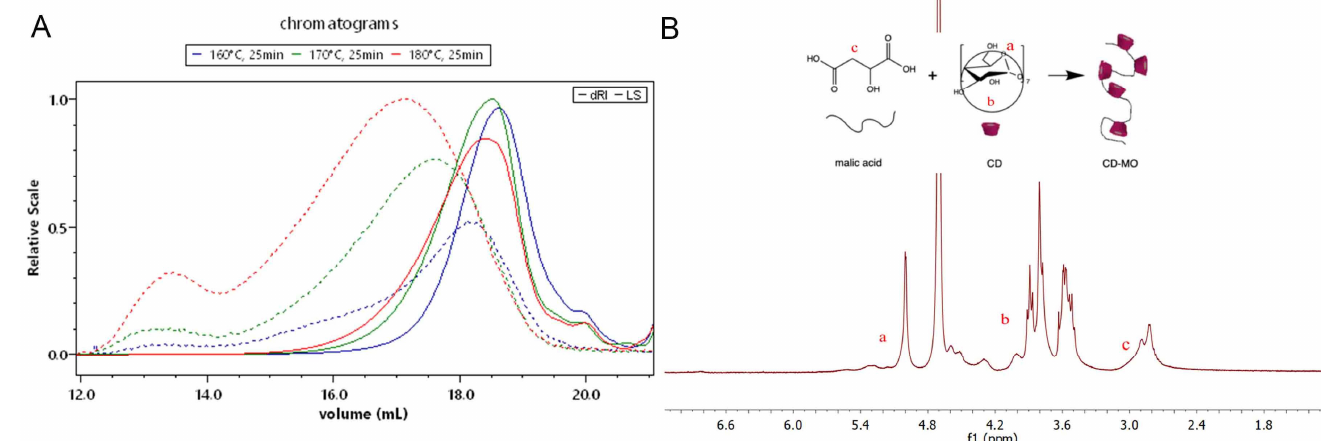
Figure 4. ( A ) SEC/MALS/DRI chromatograms of CD-MO synthesized at 160 °C (purple), 170 °C (green), and 180 °C (red) for 25 min showing both dRI and LS signals; ( B ) 1 H NMR spectrum of CD-MO synthesized at 160 °C, 25 min. Based on the integrated signals of CD units and malic acid, the evaluated ratio of CD and malic acid moieties was 1:3.